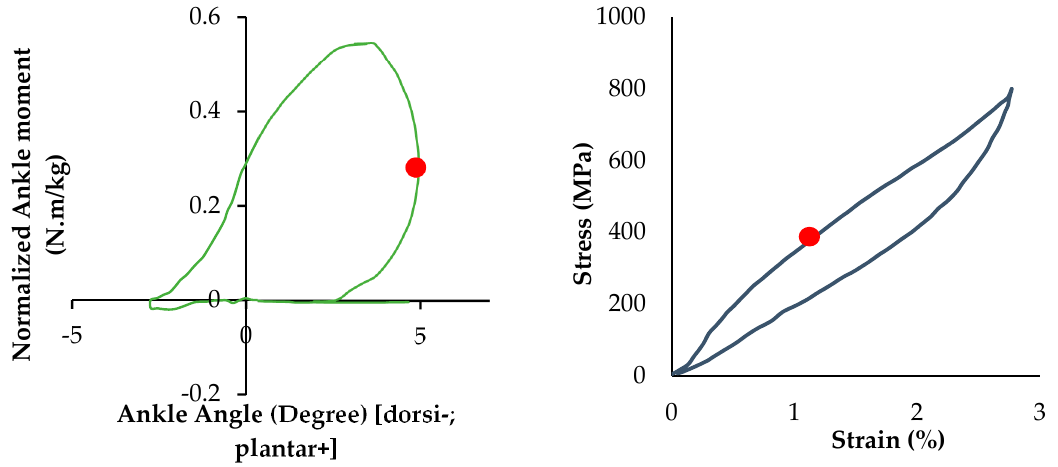
Figure 20. Corresponding stress at the maximum plantar flexion in NiTi stress).